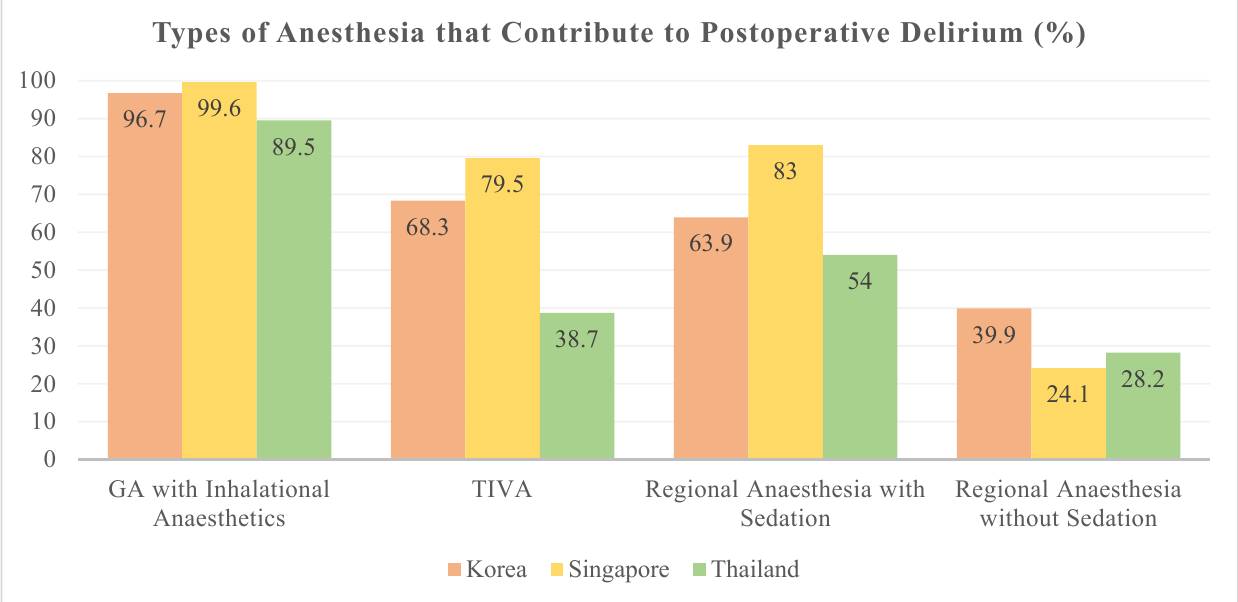
Figure 2. Perceived types of anesthesia associated with postoperative delirium among the survey respondents.